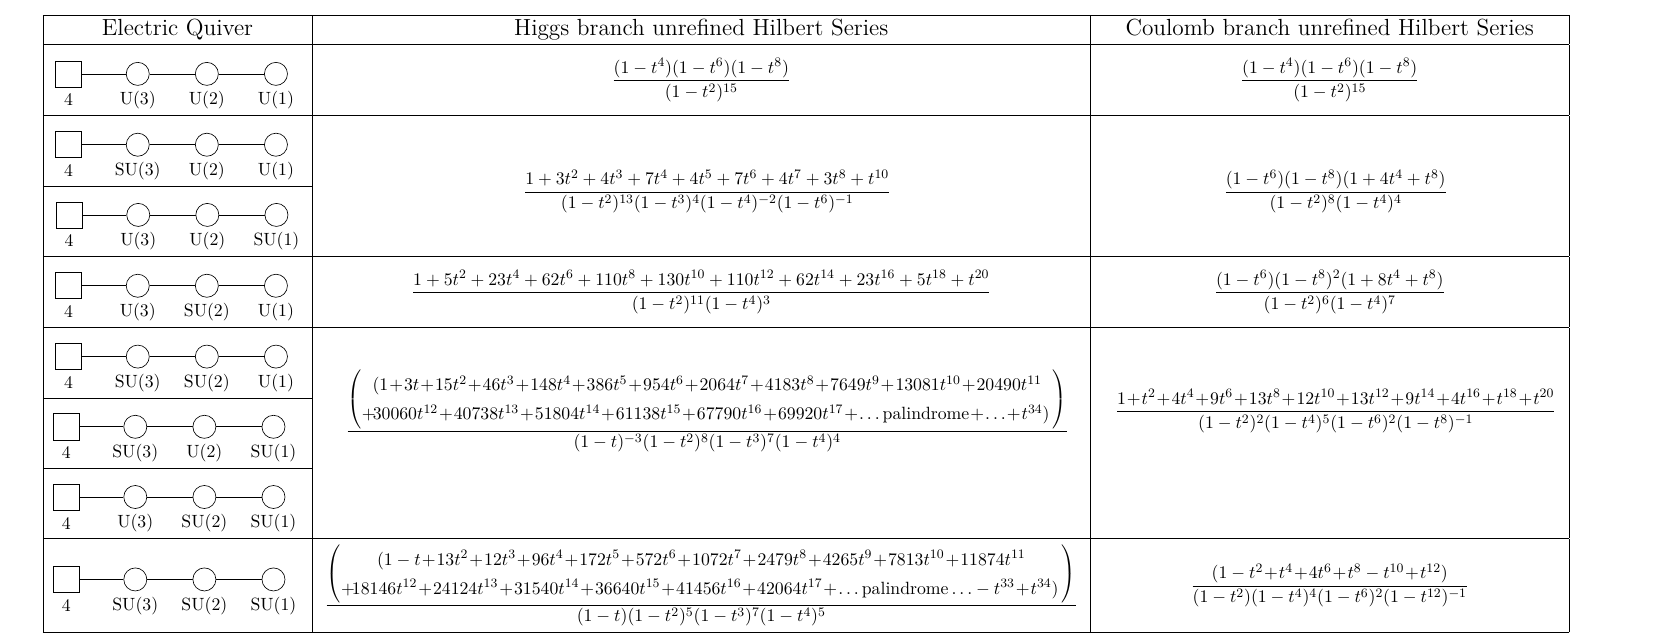
Table 3 . Extensions of the T (SU(4)) quiver are shown with different combinations of U/SU nodes, along with their Higgs and Coulomb branch unrefined Hilbert series. These correspond to the Coulomb and Higgs branch Hilbert series, respectively, of their mirror quivers shown in table 2. For brevity, unrefined Hilbert series are shown. Under the appropriate fugacity maps, this correspondence extends to refined Hilbert